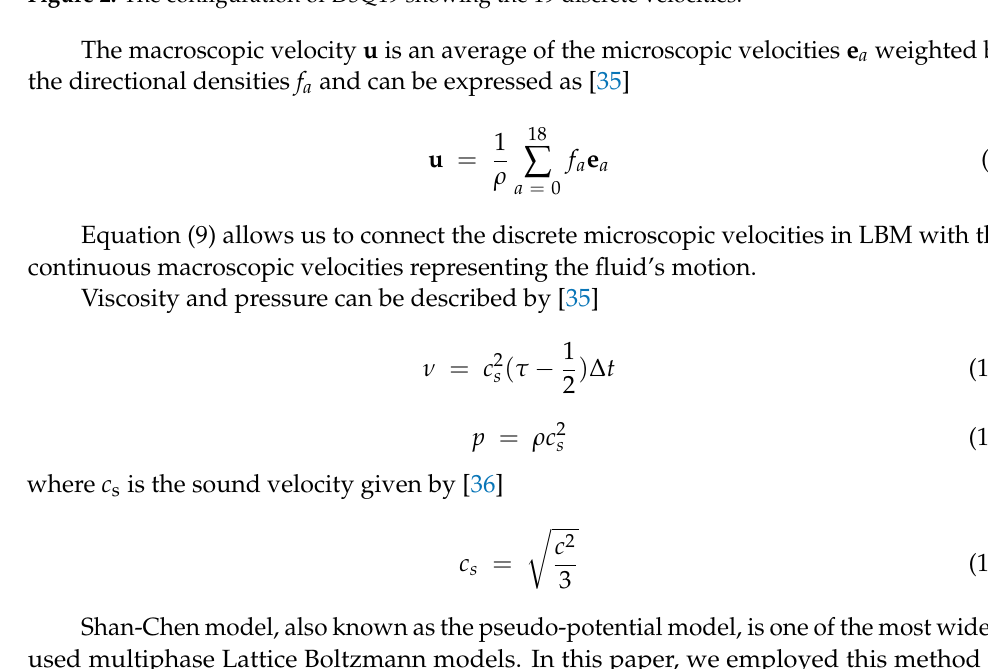
Figure 2. The configuration of D3Q19 showing the 19 discrete